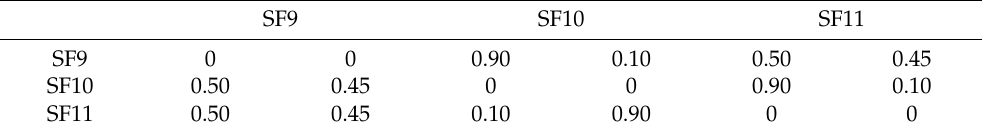
Table A1. Direct-relation matrix in Intuitionistic Fuzzy Sets—Decision-maker 1 ( Adaptability sub-criteria).